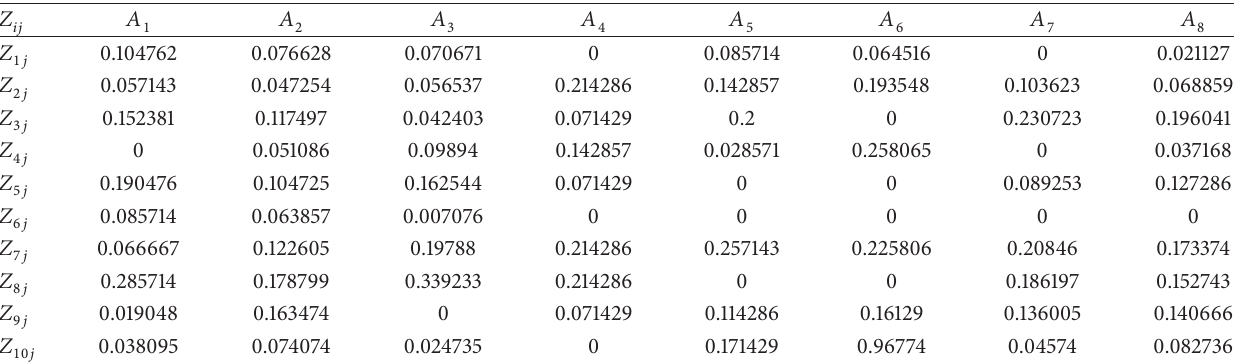
Table 4: Normalised index target centre